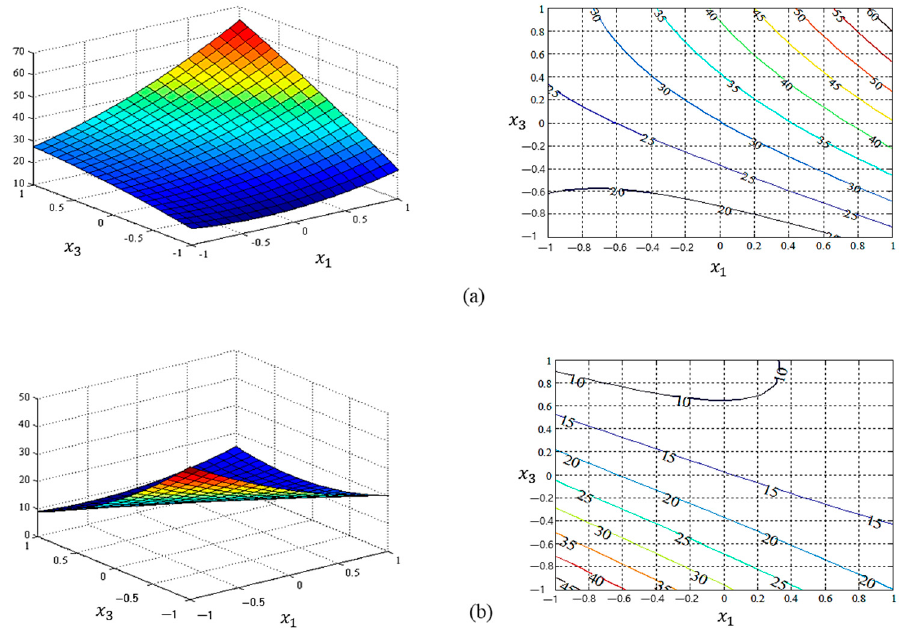
Figure A3. Graphical representation of the estimated standard deviation response functions between x 1 and x 3 : ( a ) the response surface plot and response function of LSM; ( b ) the response surface plot and response function of NN.